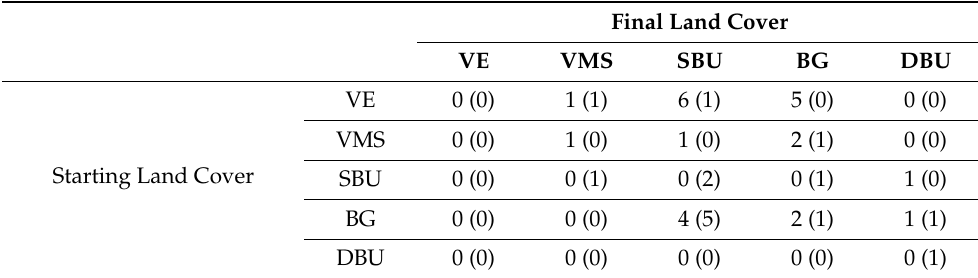
Table 7. Manual classification of pixels identified as change . Columns show final land cover, rows show original land cover. First number indicates correctly identified change (true positives); second value (in brackets) gives the number of false negatives of the change